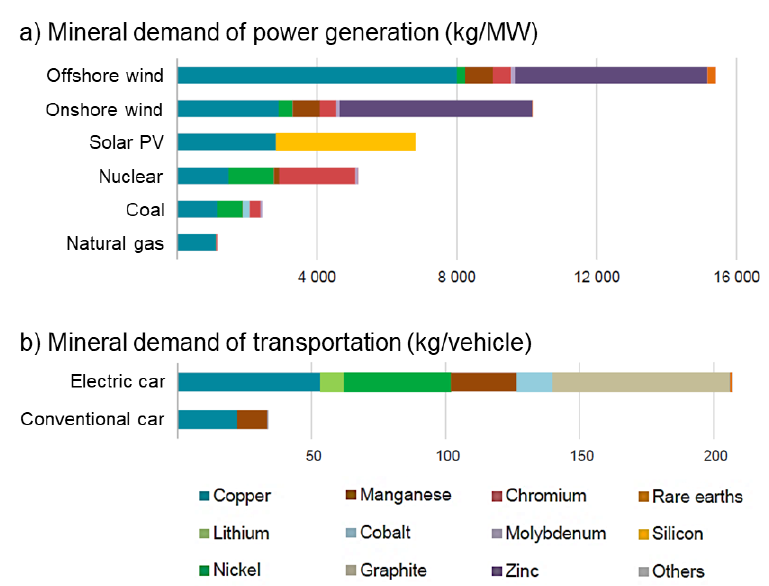
Fig. 2. – Mineral demand (a) of thermal and renewable power generation, and (b) of conventional and of electrical cars; the graph is reproduced from an IEA report [3], p.